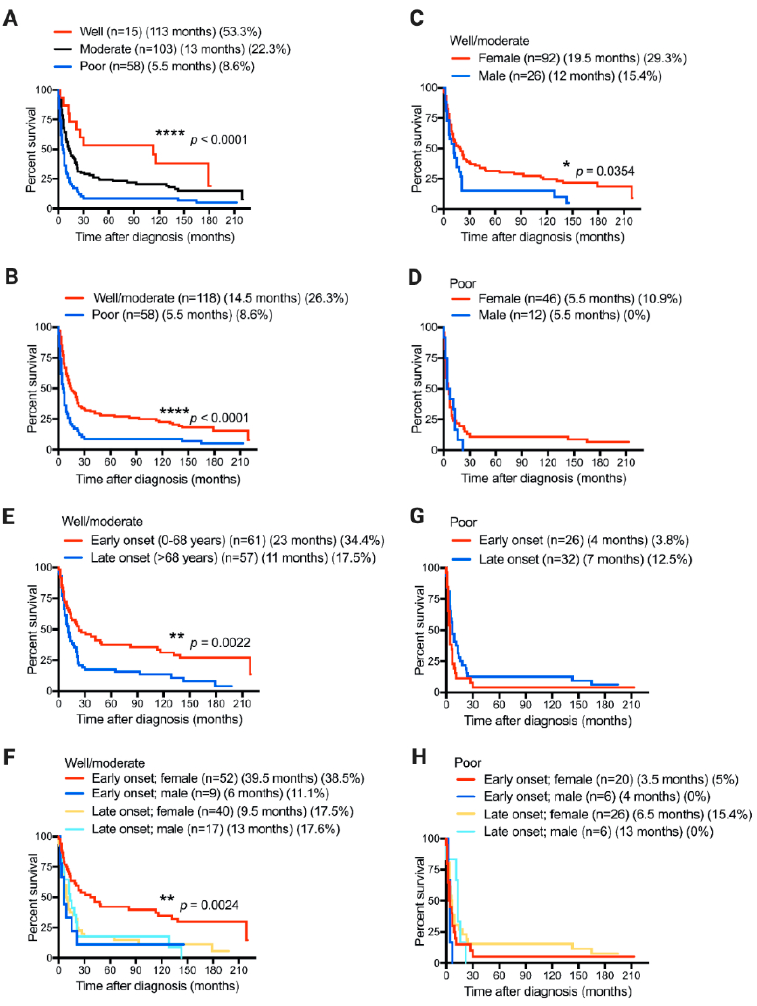
Figure 1. Tumor differentiation status, gender, and age of disease onset correlate with overall survival of gallbladder-cancer (GBC) patients. Kaplan–Meier postdiagnosis overall survival (OS) estimation of GBC patients according to ( A , B ) tumor differentiation status, ( C , D ) gender, ( E , G ) age of disease onset, or ( F , H ) age of disease onset and gender together. Each graph shows the number of patients included in each group ( n ), median OS time in months, and five-year survival rate (%). Only p values < 0.05 shown.